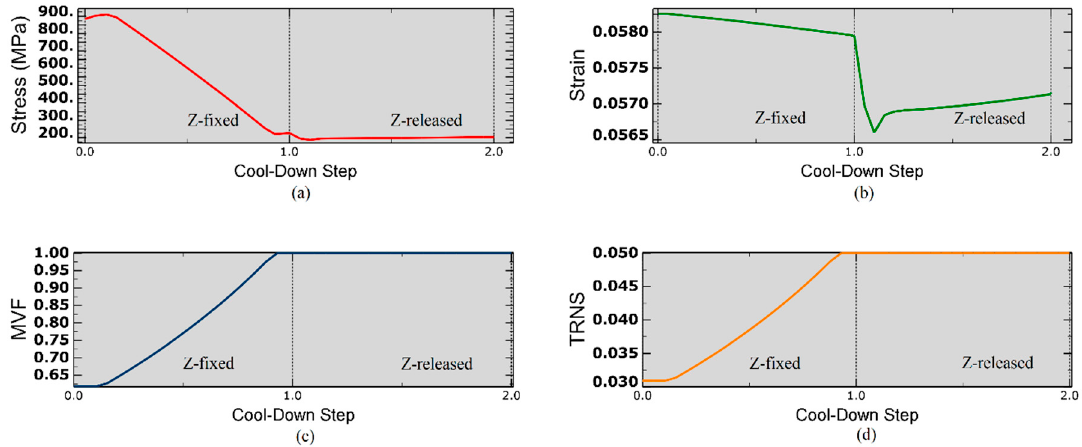
Figure 7. ( a ) Axial stress distribution; ( b ) Induced strain under thermal load; ( c ) Evolution of Martensite Volume Fraction in SMA wires; ( d ) Induced axial Transformation Strain.